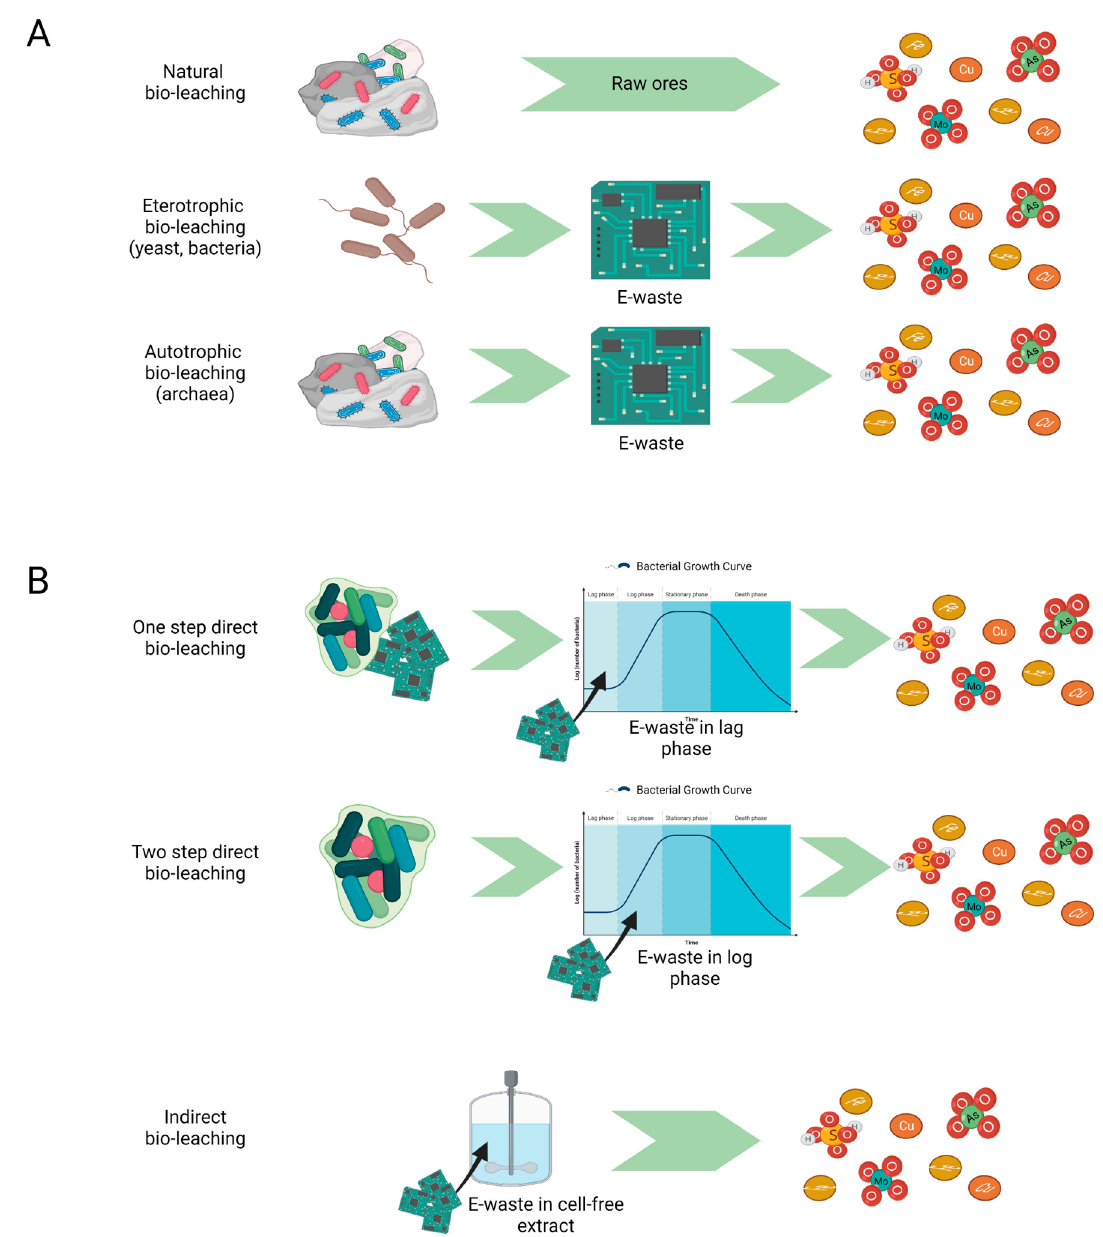
Figure 1. Bioleaching: mechanisms and strategies. ( A ) Heterotrophic and autotrophic bioleaching occurring in natural minerals deposits and in e-waste recovery processes resulting in free metal ions and metal oxides; ( B ) Direct (one-step and two-step) and indirect approach to bioleaching process. In direct bioleaching, e-waste is introduced during the initial microbial growth phase (one-step) or exponential growth phase (two-step). In indirect bioleaching, only microbial metabolites interact with e-waste.